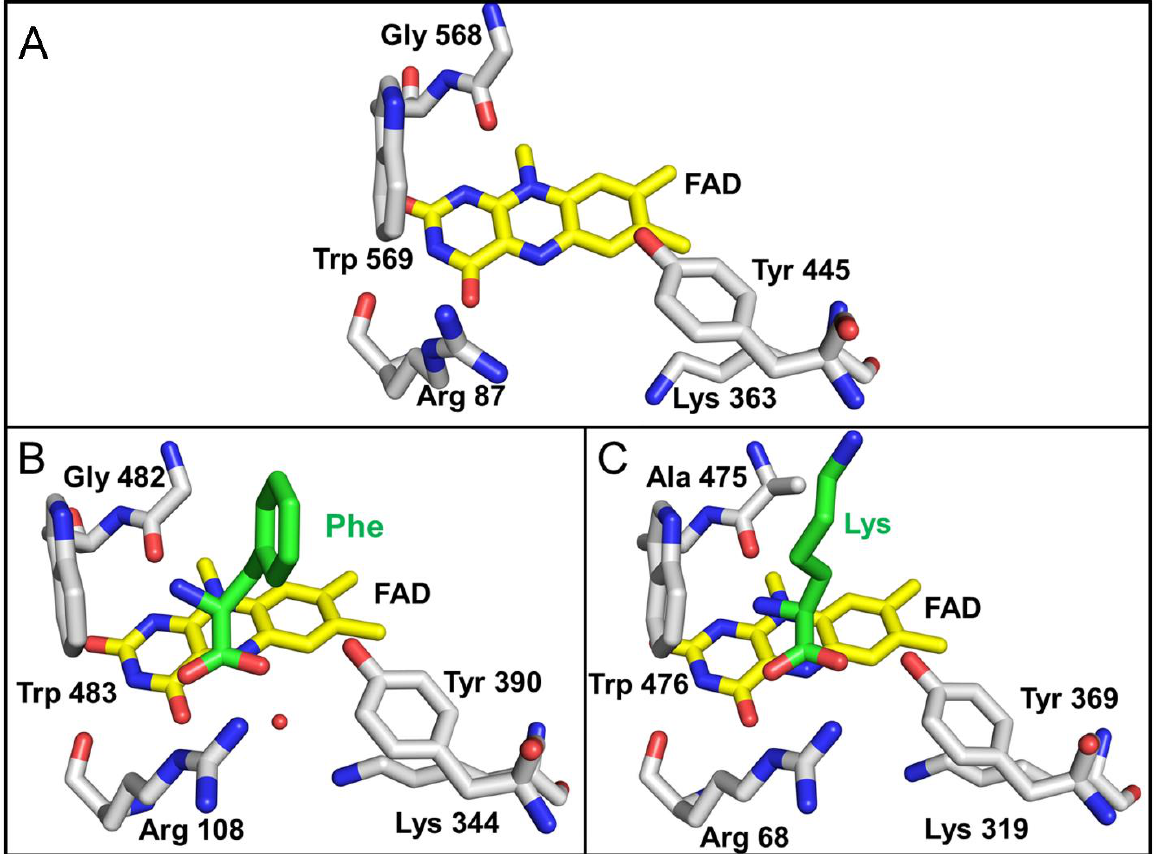
Figure 7. Active site residues that interact with the carboxyl and amino groups of the α -carbon of the amino acid substrate. ( A ) P. luteoviolacea CPMOR-1 LAAO. ( B ) SvLAAO from C. rhodostoma (PDB 2IID) with a Phe substrate present. The red sphere is a water molecule, which is coordinated by Lys344. ( C ) TvLAAO (PBD 7C3H) with a Lys substrate present. Oxygens are red, nitrogens are blue, and carbons are grey in the protein amino acids, yellow in FAD and green in the amino acid sub- strates.